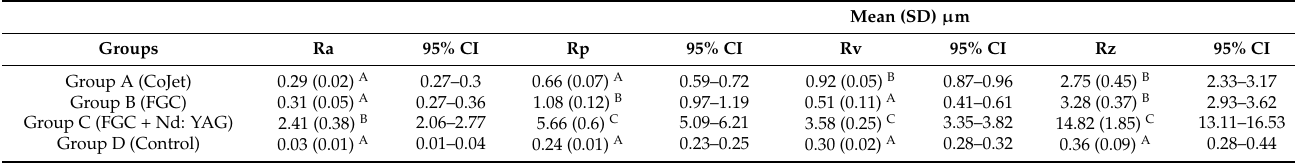
Table 1. Descriptive statistics and Tukey’s post hoc results of the mean surface roughness values arithmetic average of surface profile (Ra), an average of maximum peaks (Rp), the average of deepest valleys (Rv), and the maximum average of the highest peak and lowest valleys (Rz) ( μ m) of groups A (CoJet), B (FGC), C (FGC + Nd: YAG), and D (Control).